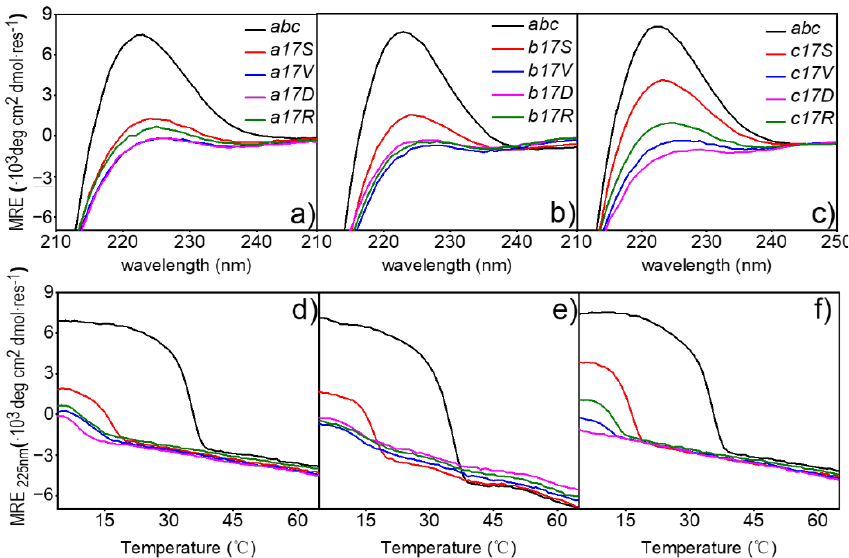
Figure 2. Thermal stability of abc and 4 mutants measured by CD spectroscopy. ( a – c ) Far-UV CD spectra ( d – f ). Thermal denaturation of host-guest peptide. Mutants are indicated by solid lines on the top right; peptides are indicated with different colors.